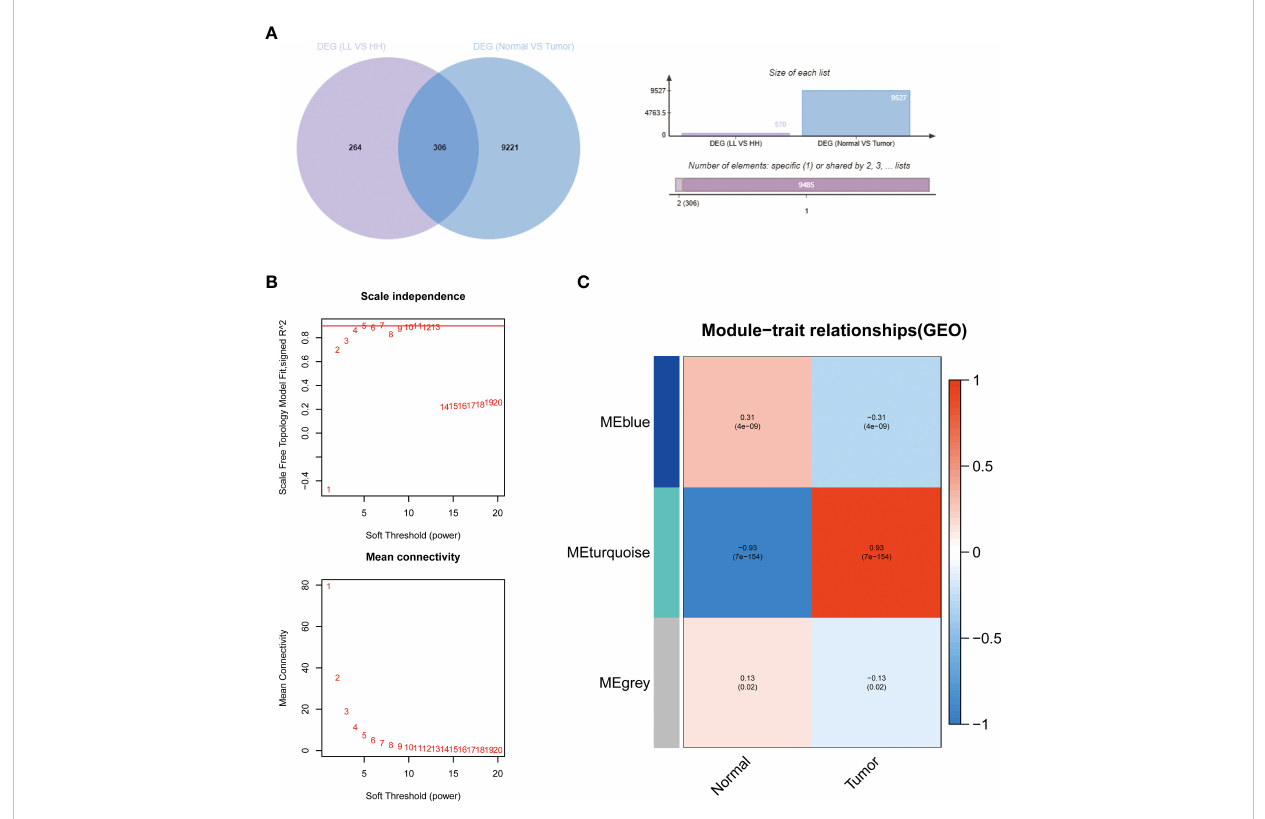
FIGURE 4 The results of WGCNA. (A) Venn diagrams of DEG (LL vs HH) and PC DEG. (B) Con fi rmation of the soft threshold for WGCNA. (C) Correlation analysis of relevant gene modules with PC.